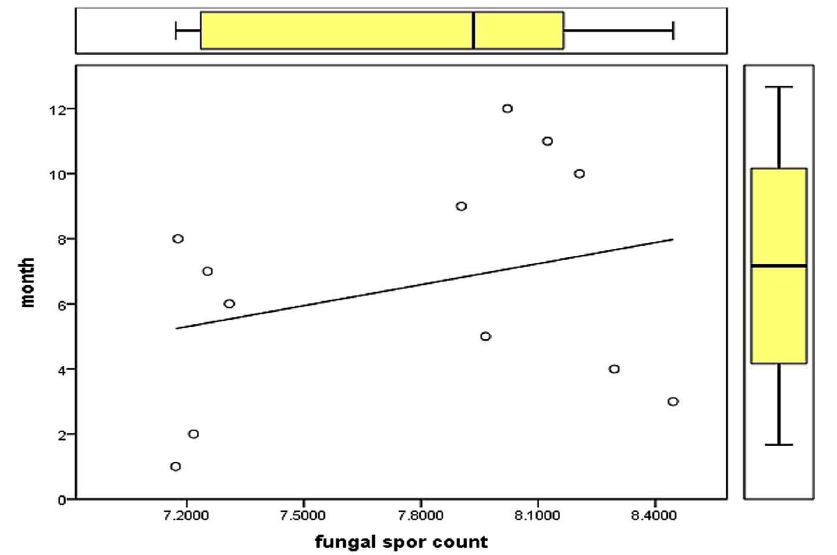
Fig. 2. Monthly distribution of log-fungal spore’s concentration in